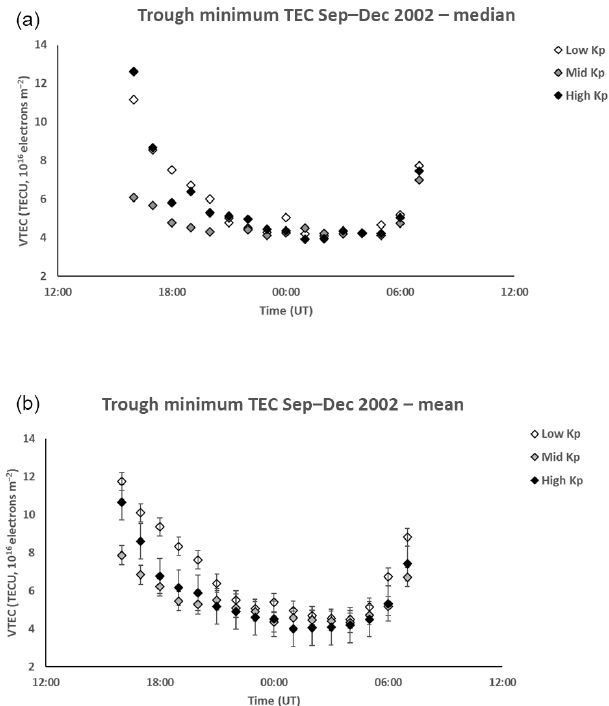
Figure 4. (a) Median VTEC for the trough minimum from 16:00 to 07:00UT for low Kp (0 to 2 + ) , medium Kp (3 − to 4) and high Kp ( ≥ 4 + ) . The representative interquartile range is approximately 2.5 TECU. Between 21:00 and 07:00UT there is no clear difference between the values for the three ranges of geomagnetic activity. (b) Mean VTEC for the trough minimum from 16:00 to 07:00UT for low Kp (0 to 2 + ) , medium Kp (3 − to 4) and high Kp ( ≥ 4 + ) . The bars show the standard error in the mean for each point. Sim- ilarly to Fig. 4a, there is no clear difference in the VTEC between the three levels of geomagnetic activity from 21:00 to